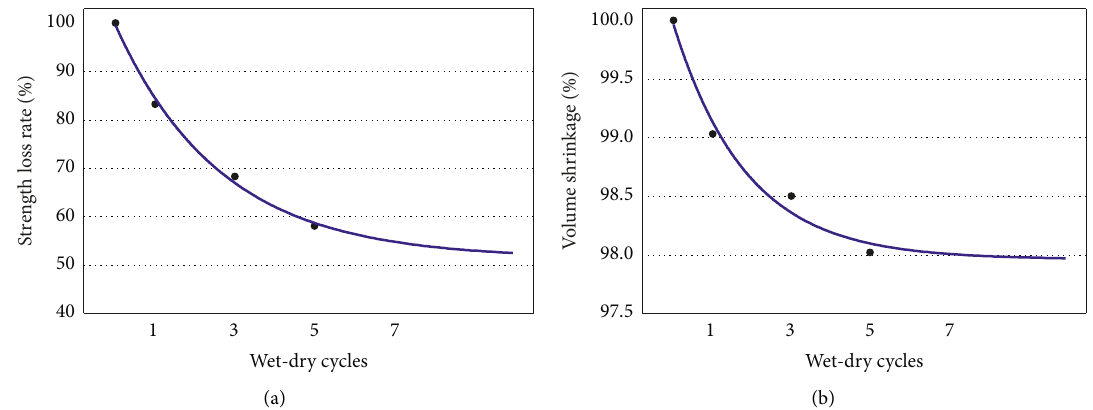
Figure 11: Effects of different wet-dry cycles on strength and volume. (a) Strength loss rate. (b) Volume shrinkage.